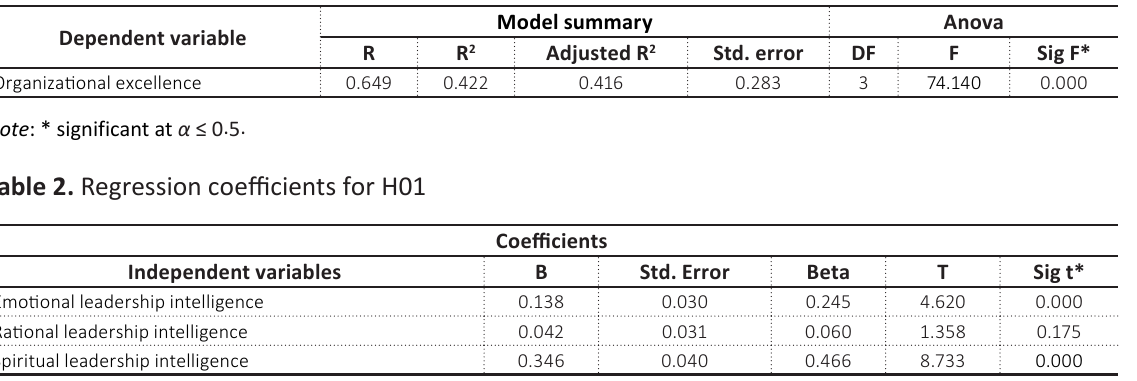
Table 1. Multiple linear regression for H01